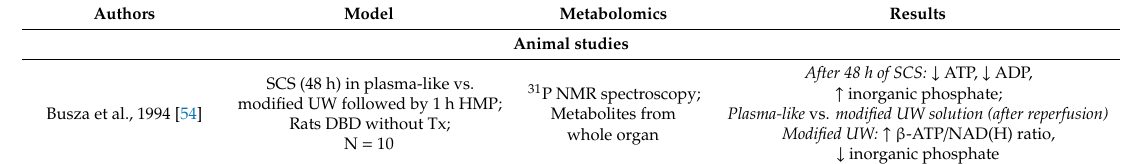
Table 4. Metabolomics in liver preservation for